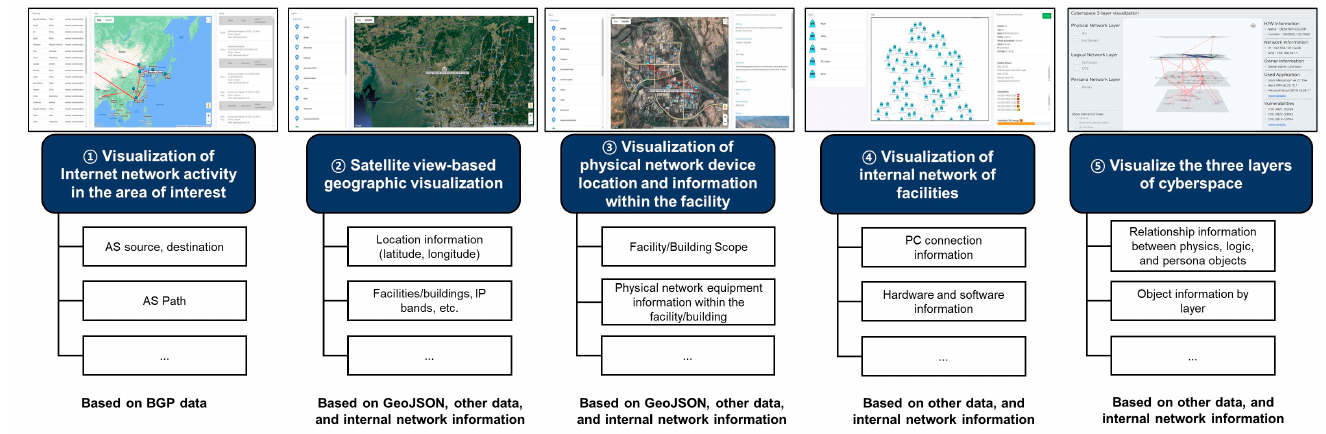
Figure 6. CyCOP Visualization Screens and Part of the Data used in each Visualization.